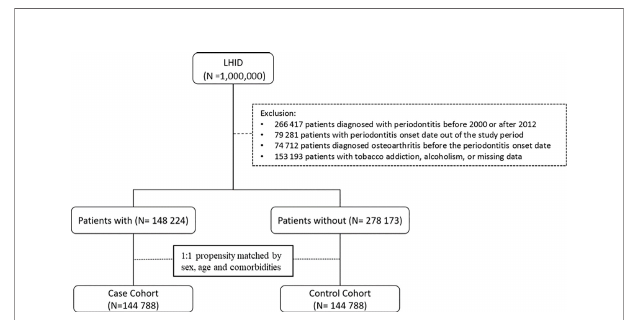
FIGURE 1 | Patient selection fl owchart for the